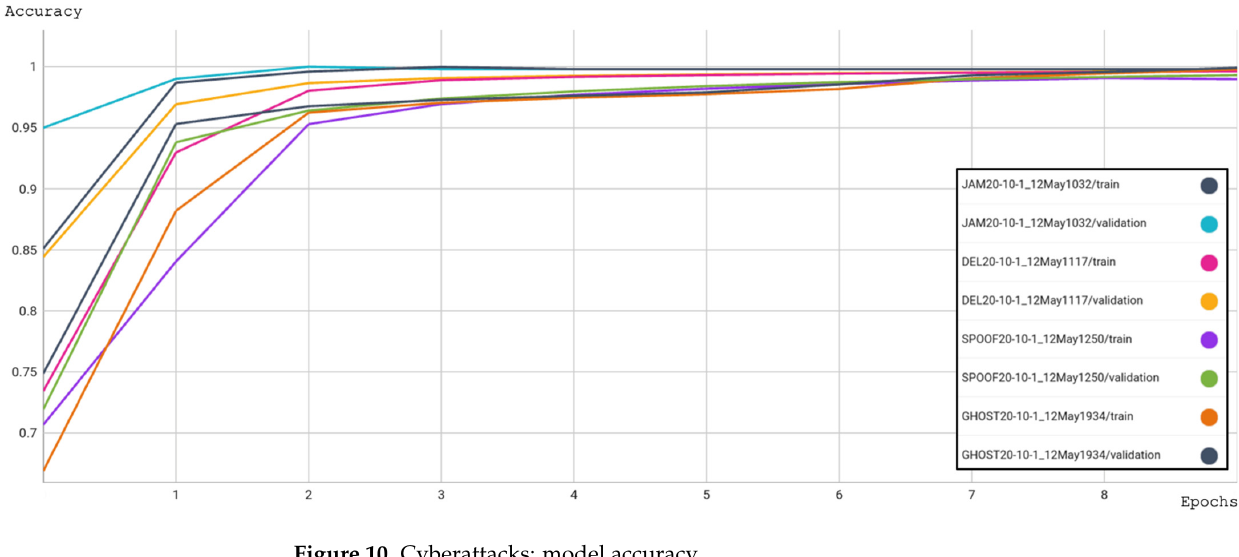
Figure 10. Cyberattacks: model accuracy.